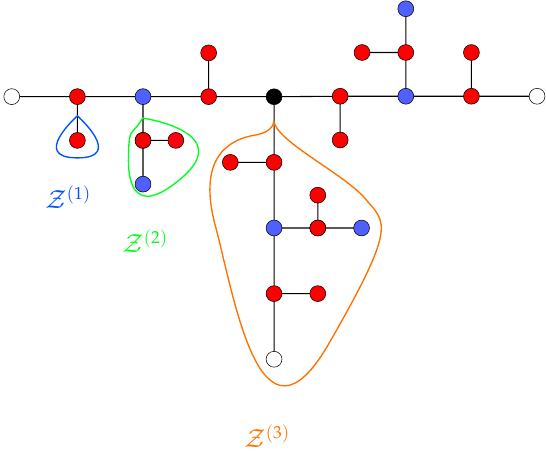
Figure 3. Branches Z Z ( G ) of different branch generation G G = 3.